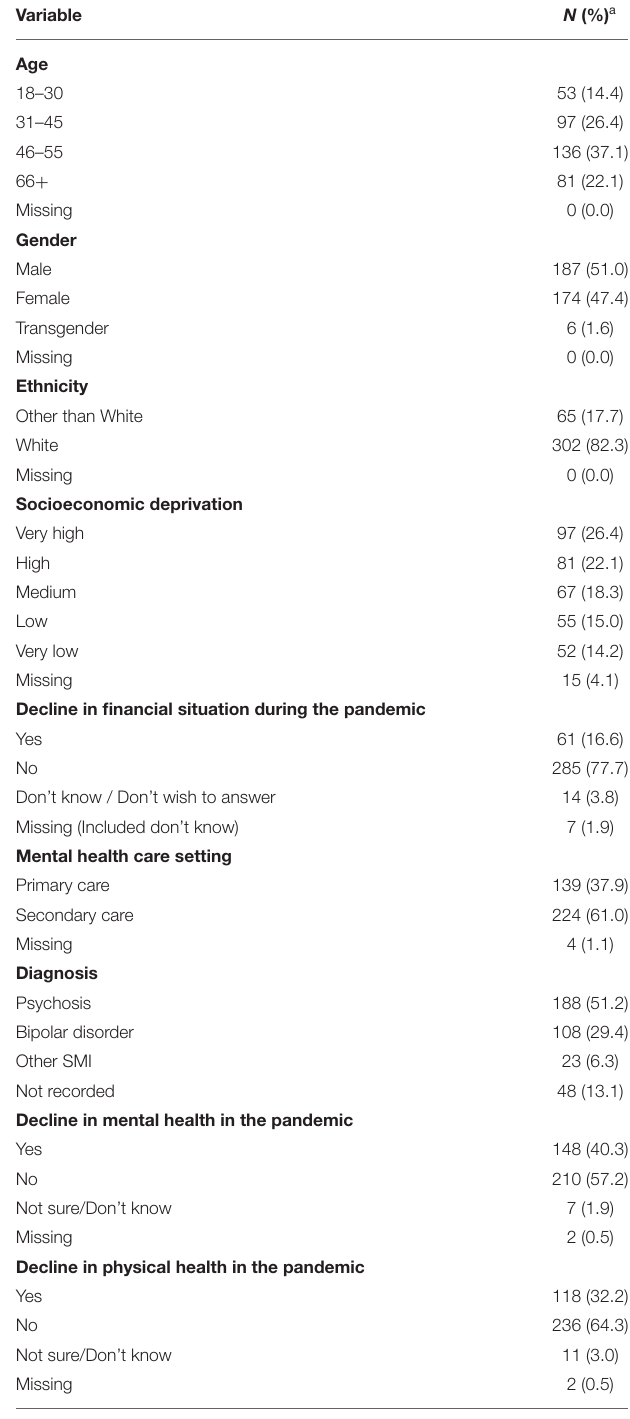
TABLE 1 | Sample characteristics and health variables ( N =